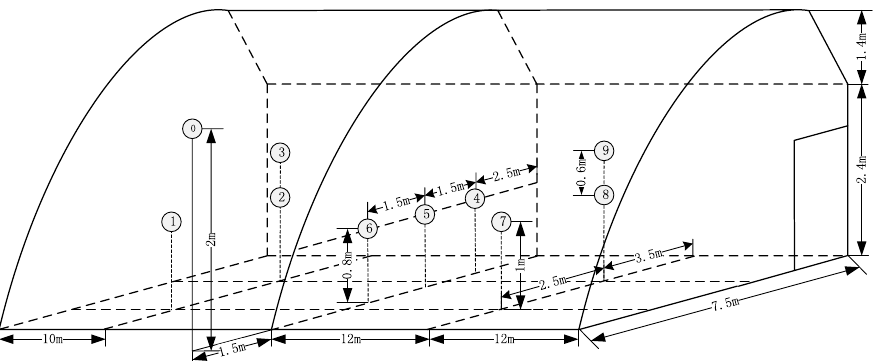
Figure 2. Schematic diagram of the solar greenhouse architecture and sensor